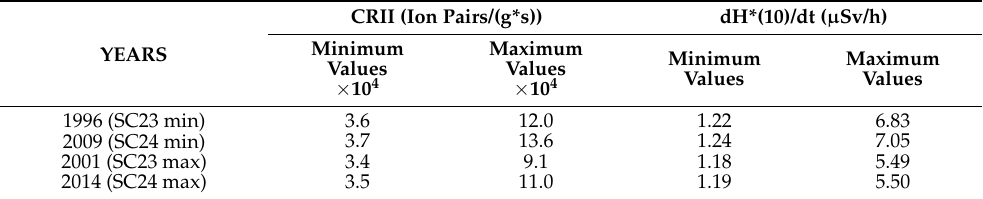
Table 1. Minimum and maximum values of CRII and the estimated ambient dose equivalent rate during the minimum and maximum of solar cycles 23 and 24 at FL390.